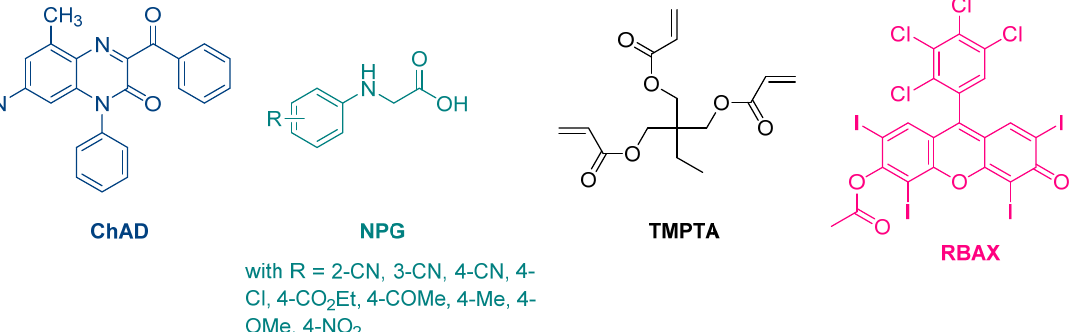
Figure 2. Chemical structures of the chromophore ChAD, the electron donors NPG, the monomer TMPTA and the reference compound RBAX.